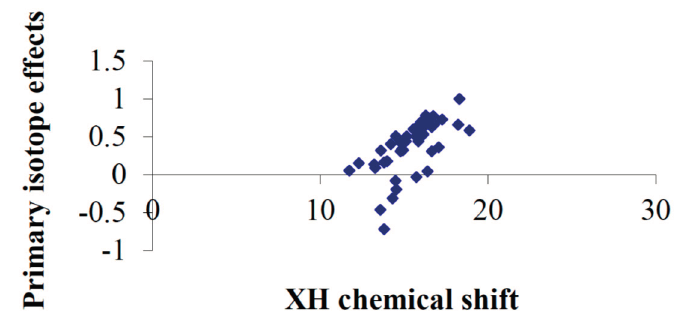
Figure 20. Plot of primary isotope effects vs. XH, X being O, N or S, chemical shifts